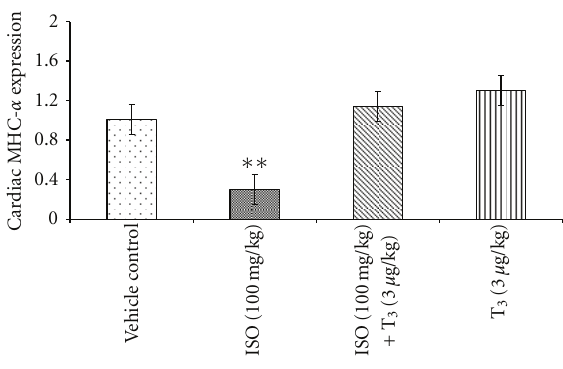
Figure 6: E ff ect of T 3 on relative expression of MHC- α . Values are presented as Mean ± SD, n = 5, ∗∗ : significant from control group at 1% level ( P < 0 . 01), SD: Standard Deviation.